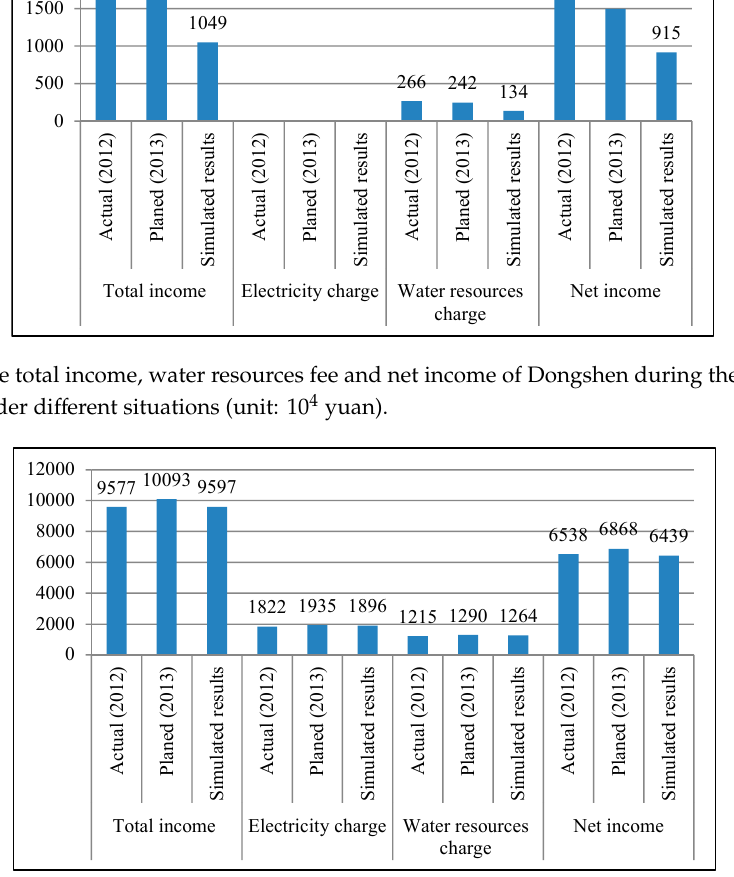
Figure 16. The total income, water resources fee and net income of Dongbu during the period from 3.2 to 3.10 under different situations (unit: 10 4 yuan).